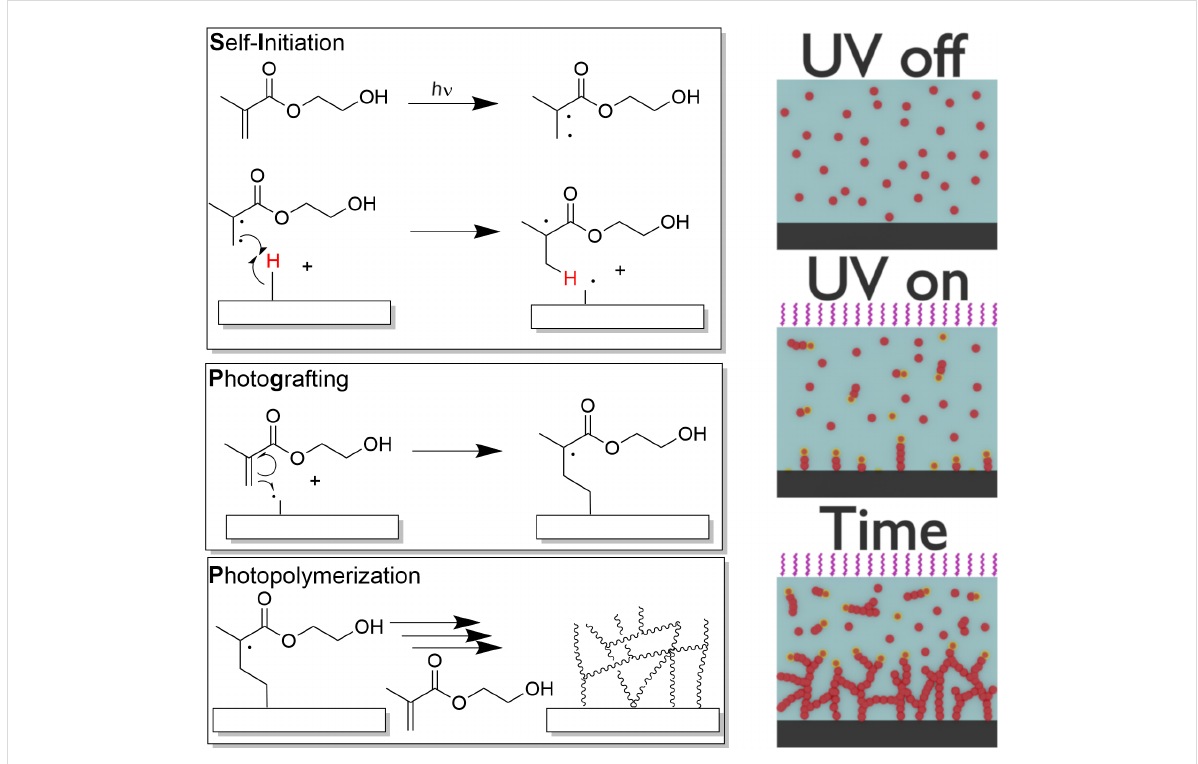
Scheme 1: Schematic representation of the self-initiated photografting and photopolymerization (SIPGP) of 2-hydroxyethyl methacrylate (HEMA) in- cluding intersystem crossing from singlet to triplet state which is mandatory for the formation of a biradical (left). Cartoon how SIPGP leads to surface- initiated polymerization and bulk polymerization (monomer red, active species red/yellow halo) (right).